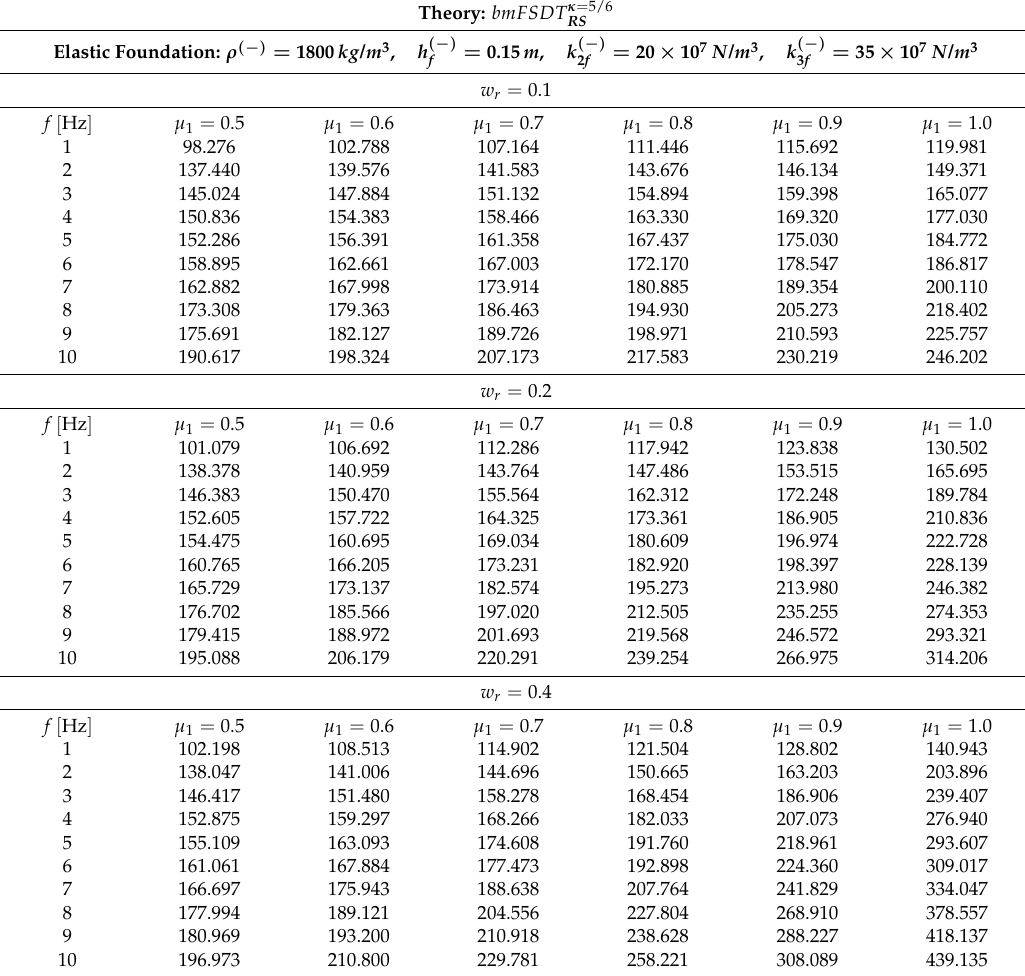
Table 8. First ten natural frequency variations for FSDT κ = 5/6 (Figure 4c) reinforced by CNTs distributed as in Figure 5c for different mass fractions w r when varying the parameter of agglomeration µ 1 with µ 2 = 1. The Chebyshev-Gauss-Lobatto grid distribution was employed, with I N = 31, I M =